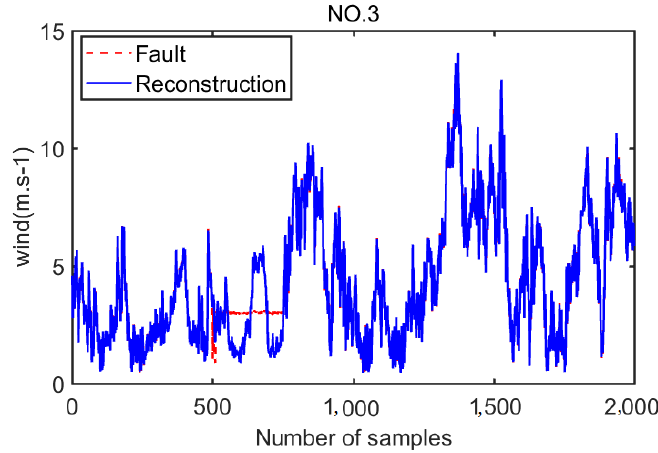
Figure 5. Single invalidation fault status of the six anemometers: ( a ) Residual curve of WTG 1; ( b ) Residual curve of WTG 2 ( c ) Residual curve of WTG 3 ( d ) Residual curve of WTG 4 ( e ) Re- sidual curve of WTG 5 ( f ) Residual curve of WTG 6